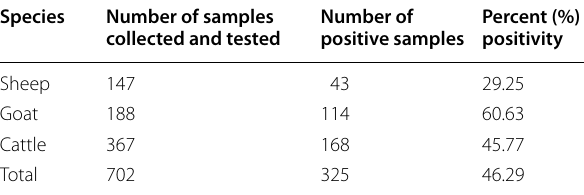
Table 6 Seroprevalence of anti-BTV antibodies among Assam animals Species Number of samples collected and tested Sheep